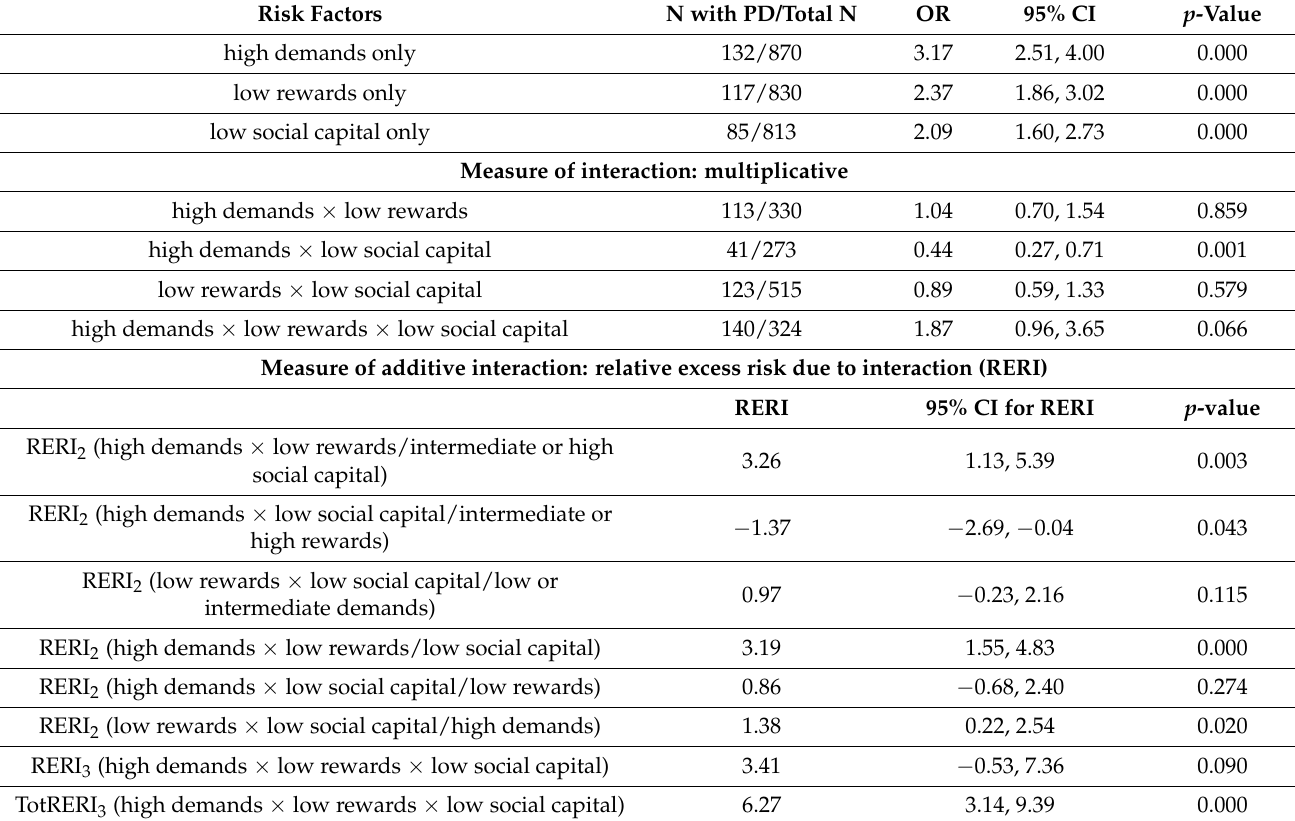
Table 2. Odds ratios of high demands, low rewards, and low social capital and their production terms from a binary logistic regression analysis of psychological distress on an individual level, with indices of additive (relative excess risk due to interaction) and multiplicative interaction.